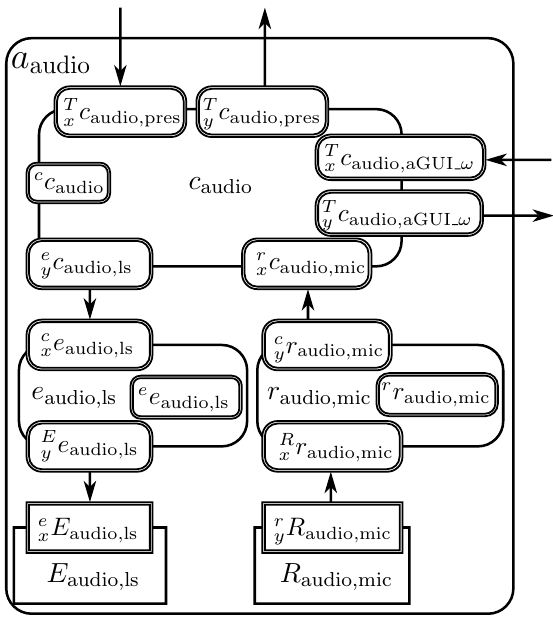
Figure 14. Structure of the audio agent a audio , where ω ∈ { init,user,cmd,ctrl } .